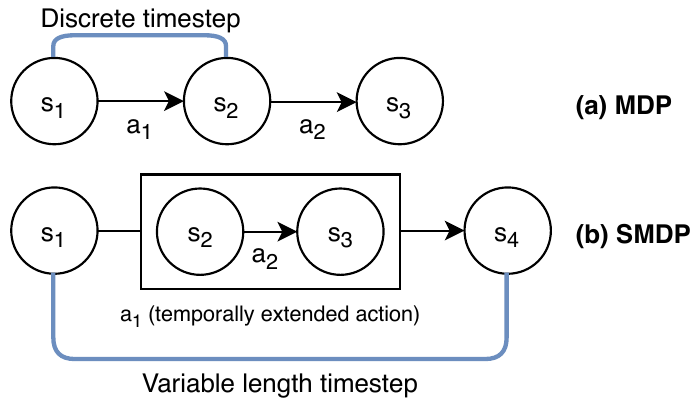
Figure 1. The MDP framework differs from an SMDP, in that an SMDP allows the length between timesteps to be variable. This is an essential property to support temporally extended